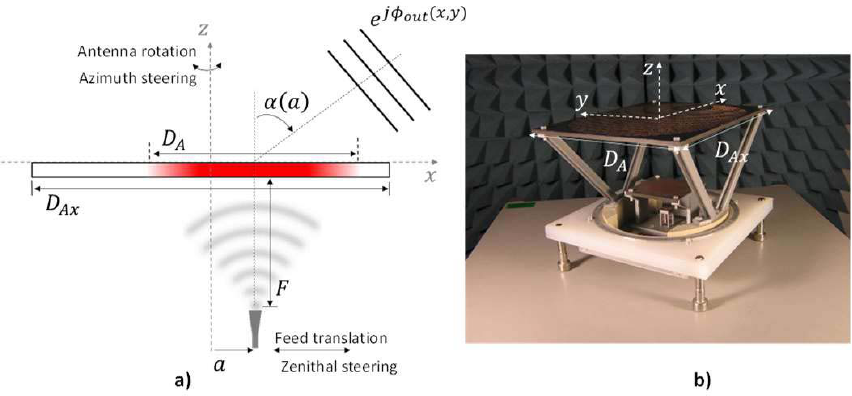
Figure 10. ( a ) Working principle of the hybrid beam scanning antenna. ( b ) Fabricated prototype. (Reprinted with permission from [76]).